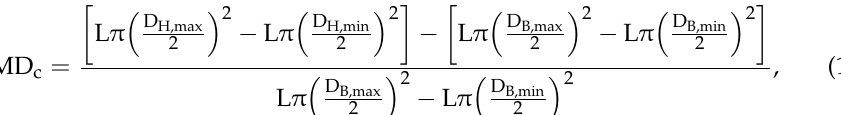
Figure 2. Interaction between the brachial artery and the cuff bladder: ( a ) relationship of the artery pressure to volume, ( b ) relationship of the cuff pressure to volume. Δ V a causes an effect on the cuff bladder, Δ V c . When Δ P c and Δ V c are very small, the compliance ( C c ) is defined as the ratio of Δ V c and Δ P c .